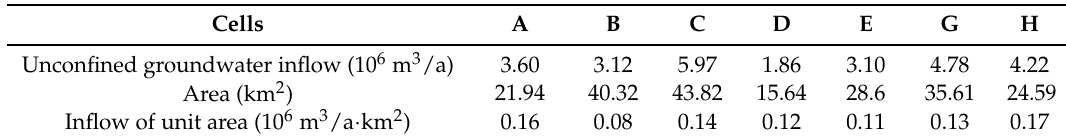
Table 5. Unit area recharge quantity from the upper unconfined aquifer.